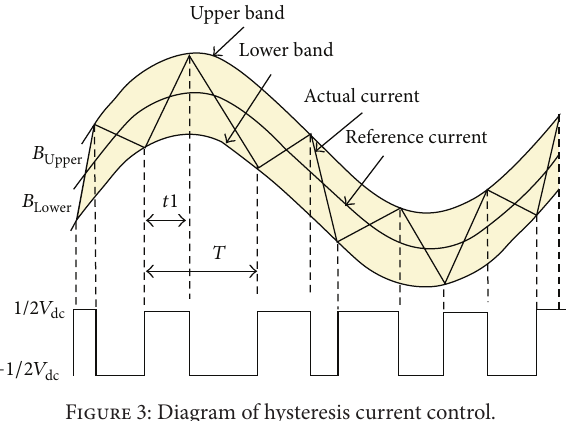
Figure 3: Diagram of hysteresis current control.